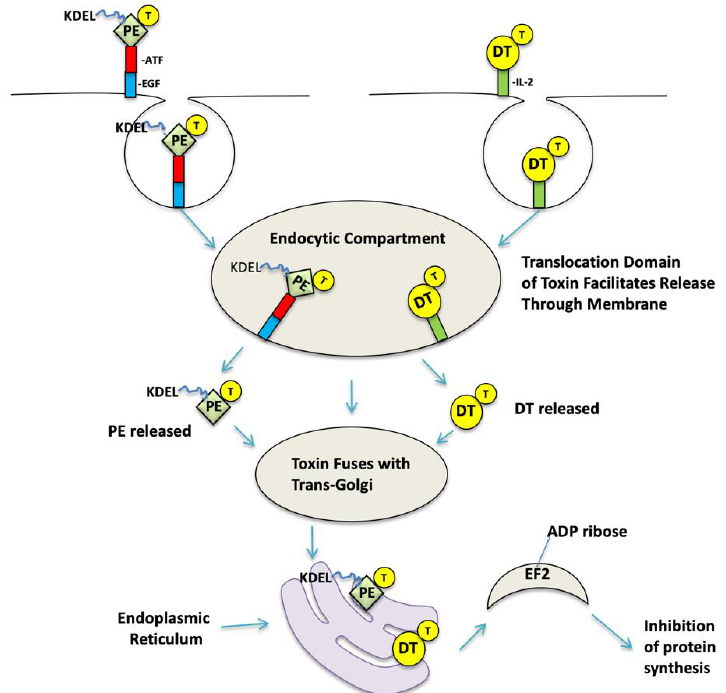
Figure 1. Intoxification Pathway. The figure shows the intoxification of Pseudomonas aeruginosa exotoxin A (PE)-based EGFR-targeted bispecific angiotoxin (eBAT) and DTIL2 (Ontak).